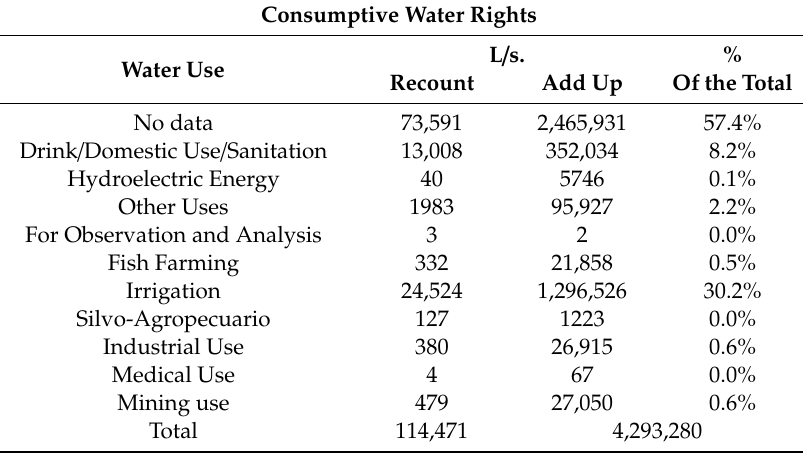
Table 1. Consumptive water rights by use, including “No data” cases. Source: Author’s elaboration based on DGA data.